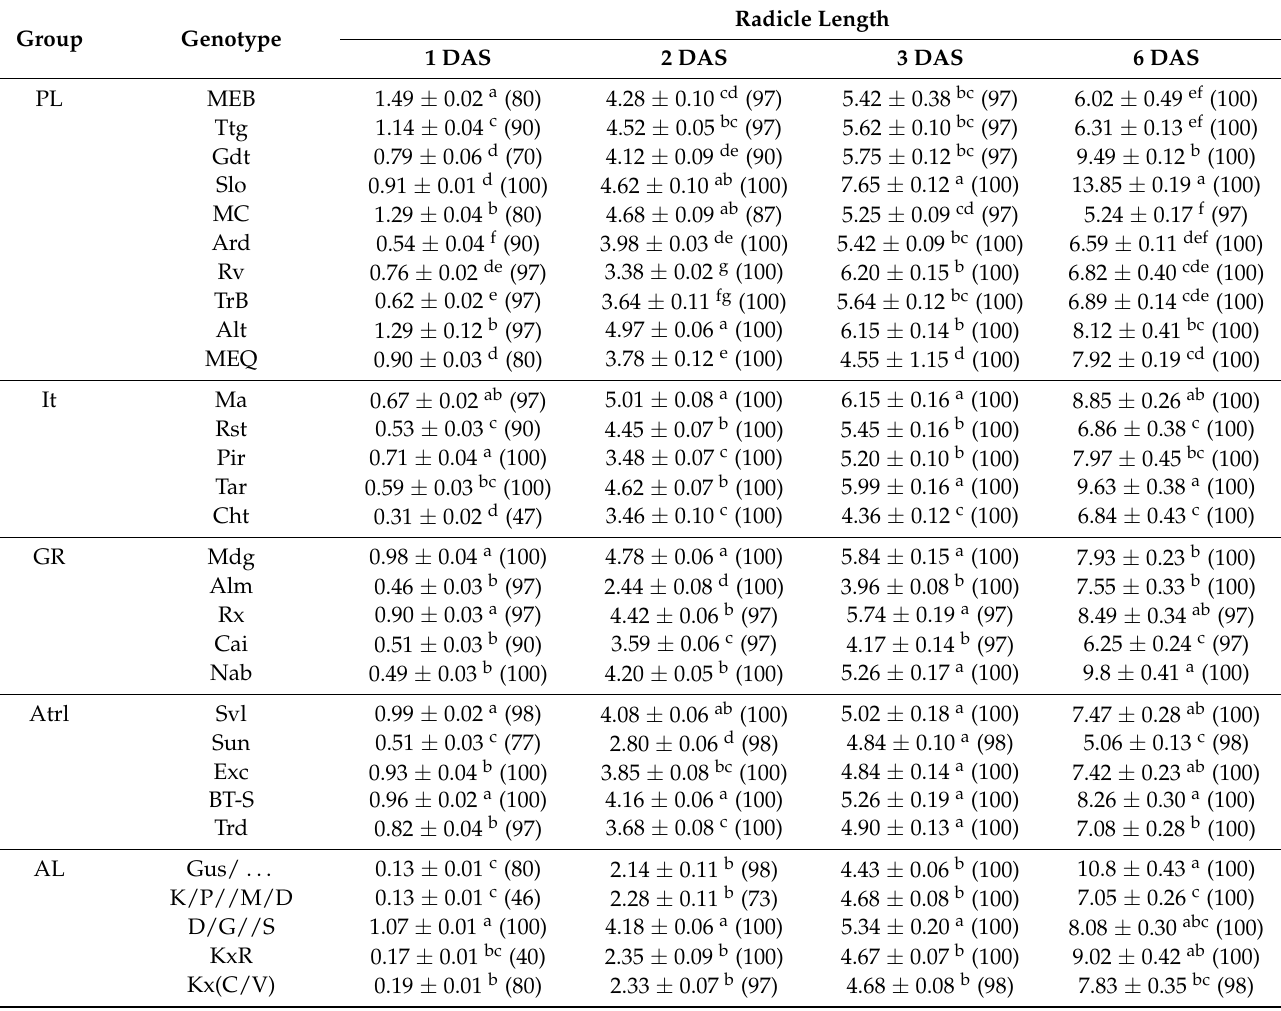
Table 1. Radicle length (cm) and germination percentage (in parenthesis) at 1, 2, 3 and 6 days after sowing (DAS) of 30 bread wheat genotypes belonging to five evolutive/breeding groups. For each genotype, the mean values ± SE ( n = 24–60) followed by different letters express significant differences (a, b, c, d, e, f) for a 95% confidence level. The highest value corresponds to the letter a. PL— Portuguese Landraces; It—Italians; GR—Green Revolution; Atrl—Australians; AL—Advanced